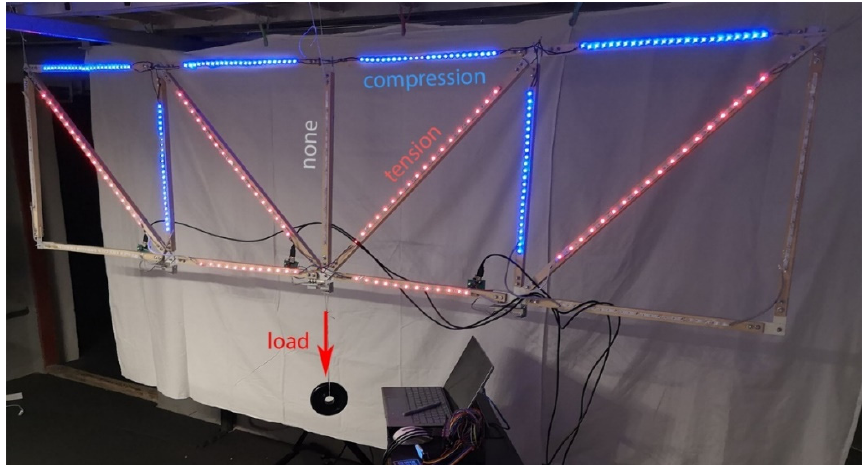
Figure 6. Truss under loads.